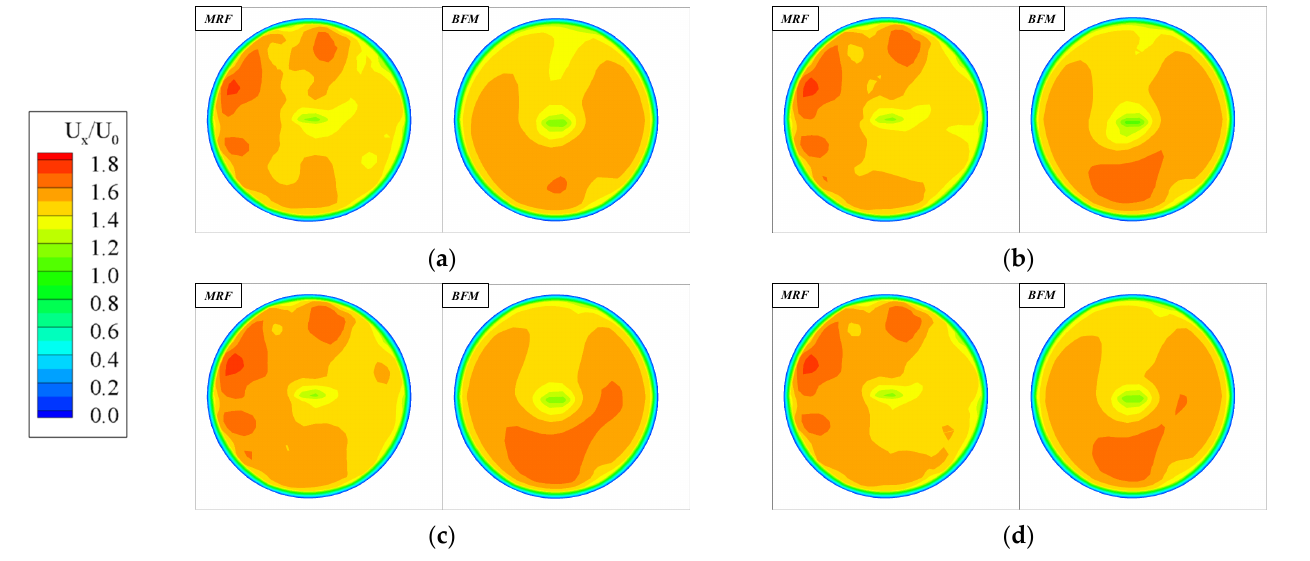
Figure 17. Comparison of non-dimensional axial velocity distribution of the MRF model and body- Table 6. Results of NVR , Q J and β M 6 at station 6 with the MRF model and body-force model (BFM).